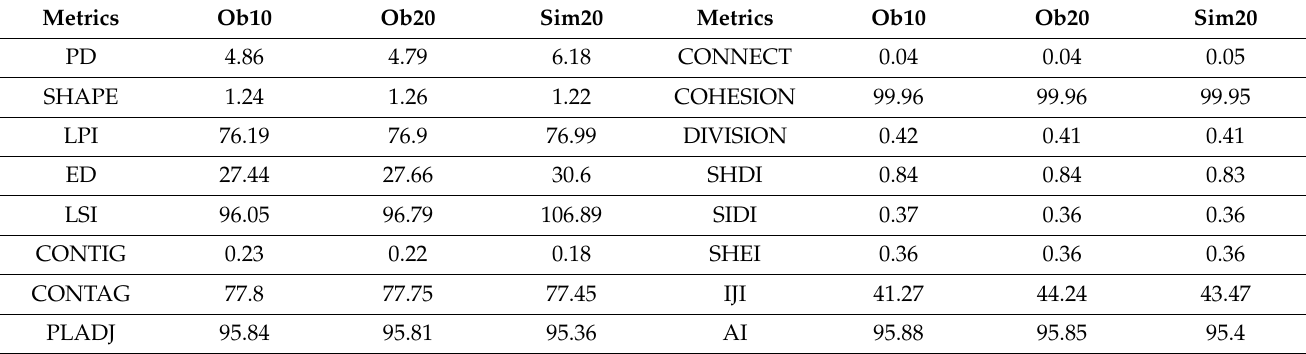
Table A3. Observed and simulated landscape pattern metrics of